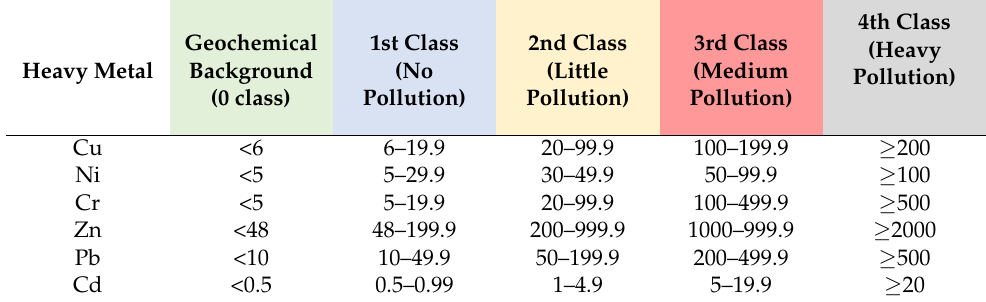
Table 2. Classification of heavy metals in sediments according to the geochemical method